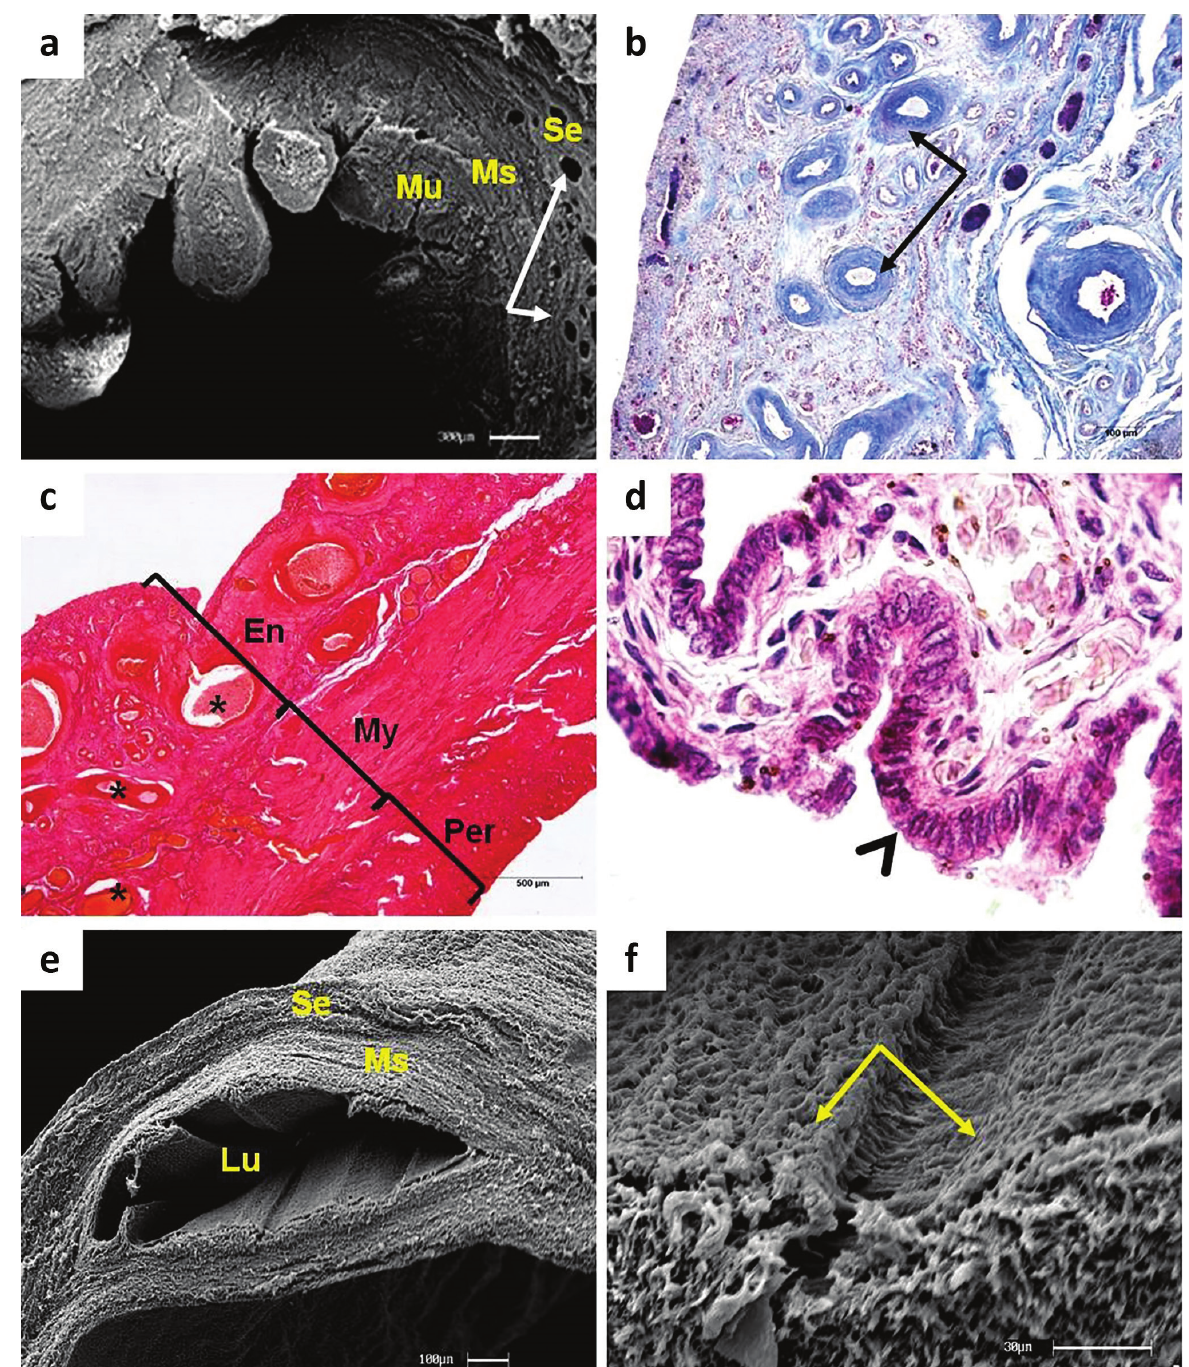
Figure 2 - Photomicrograph of uterine cervix (a) , corpus uteri (b, c) and oviduct (d, e, f) of Sotalia guianensis . a. Scanning electron photomicrograph of a cervix from a young female. Mucosa (Mu), muscle (Ms) and serosa (Se) layers with the presence of blood vessels (arrows). b. Blood vessels (arrows) in the uterine submucosa. 10x. Masson’s Trichrome. c. Endometrium (En), myometrium (My) and perimetrium (Per). Presence of several blood vessels (*). 4x. Sirius-red. d. Simple columnar epithelium of the oviduct (arrowhead). 100x. Hematoxylin-Eosin. e, f. Scanning electron photomicrographs. e. Pleated lumen (Lu) of the oviduct mucosa. Muscle (Ms) and serosa (Se) layers. f. Presence of folds (arrows) in the